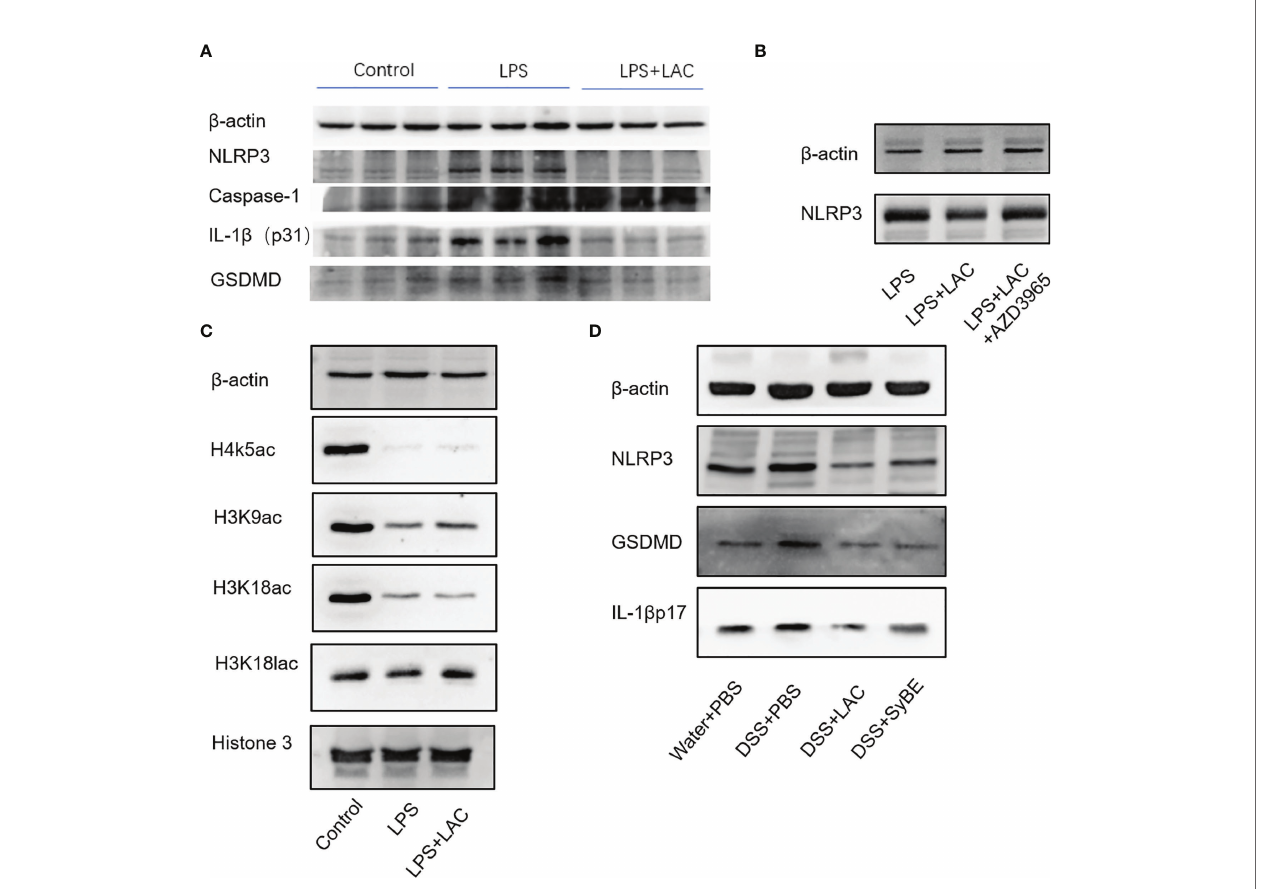
FIGURE 5 | Lactic-acid and Saccharomyces cerevisiae inhibited NLRP3 in fl ammasome activation in vivo and in vitro . (A) Lactic acid downregulated the expressions of NLRP3, caspase-1, IL-1 b p31, and gasdermin D (GSDMD) in bone marrow-derived macrophages (BMDMs). (B) With AZD3965 pretreatment, lactic acid did not inhibit the expression of NLRP3 upon stimulation with LPS in BMDMs. (C) Lactic acid enhanced the expressions of H3K9ac and H3K18lac in BMDMs. (D) Lactic acid and SyBE inhibited the expressions of NLRP3, GSDMD, and IL-1 b p17 in dextran sulfate sodium (DSS)-induced